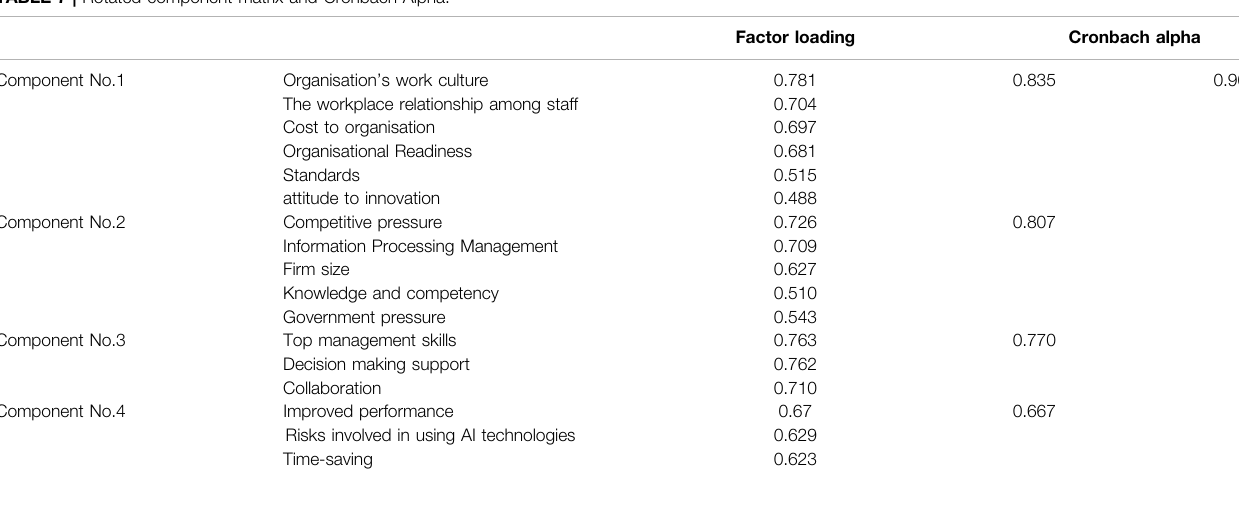
TABLE 7 | Rotated component matrix and Cronbach